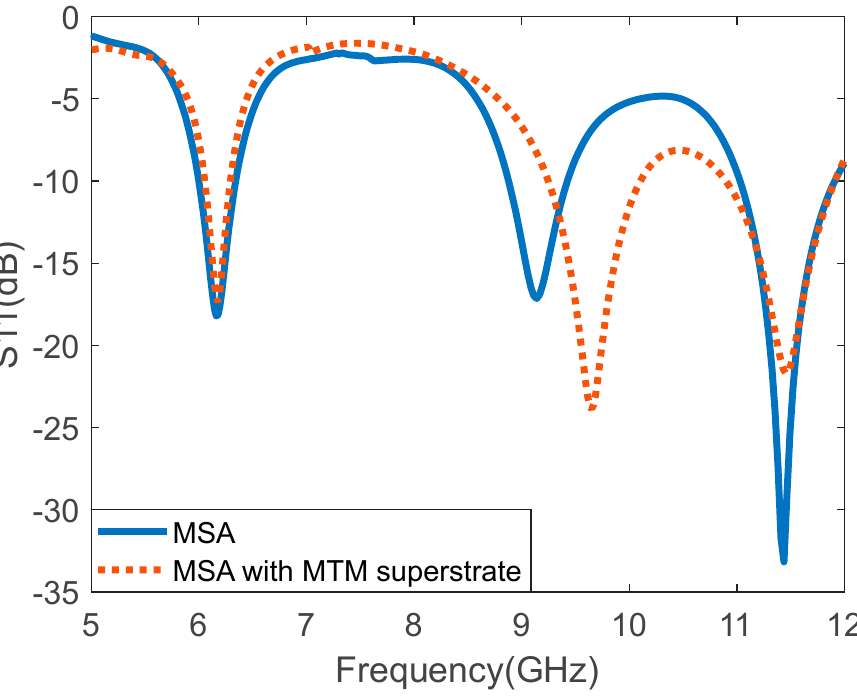
Figure 6. Simulated reflection coefficient ( 𝑆11 ) of the rectangular MPA and I-shaped MTM array- based rectangular MPA.